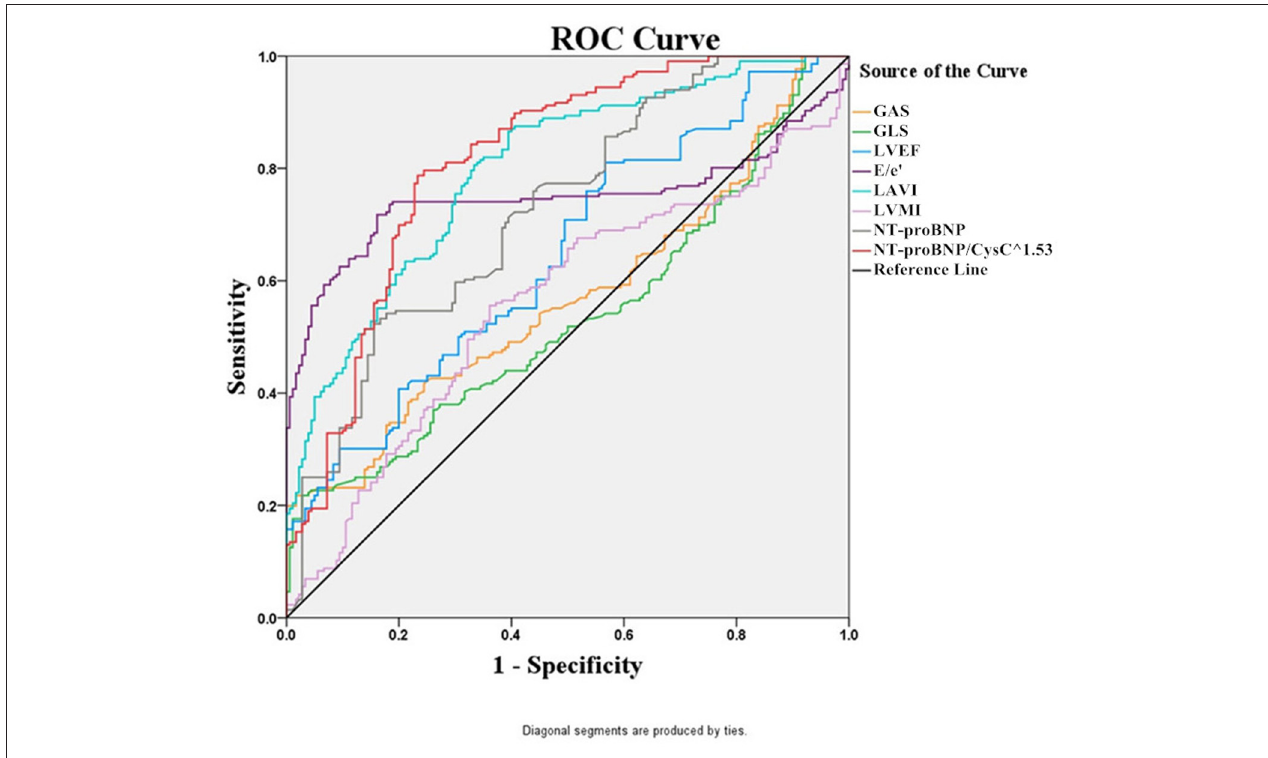
FIGURE 2 | The ROC curves of NT-proBNP/CysC 1.53 , NT-proBNP, GAS, GLS, LVMI, LAVI, E/e’, and LVEF for the diagnosis of HF in patients with CKD.